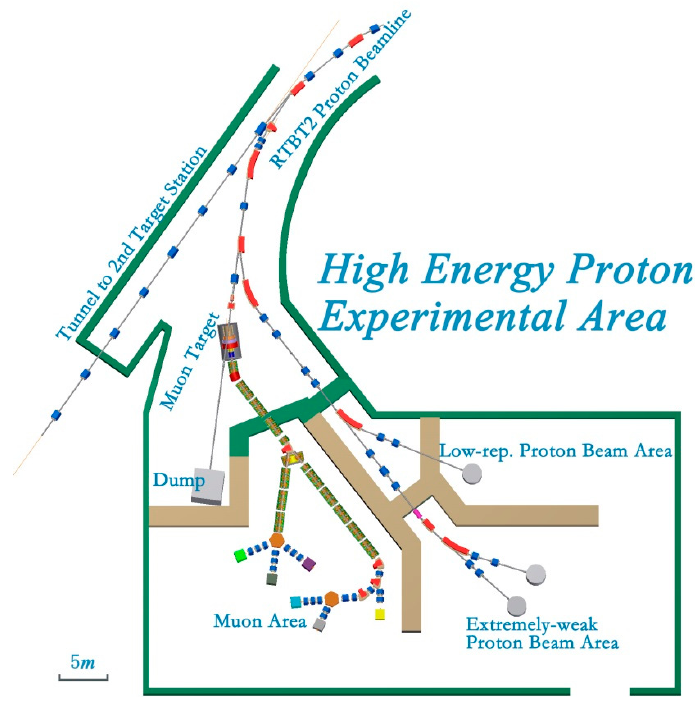
Figure 2. Layout schematic for the high-energy proton experimental area.